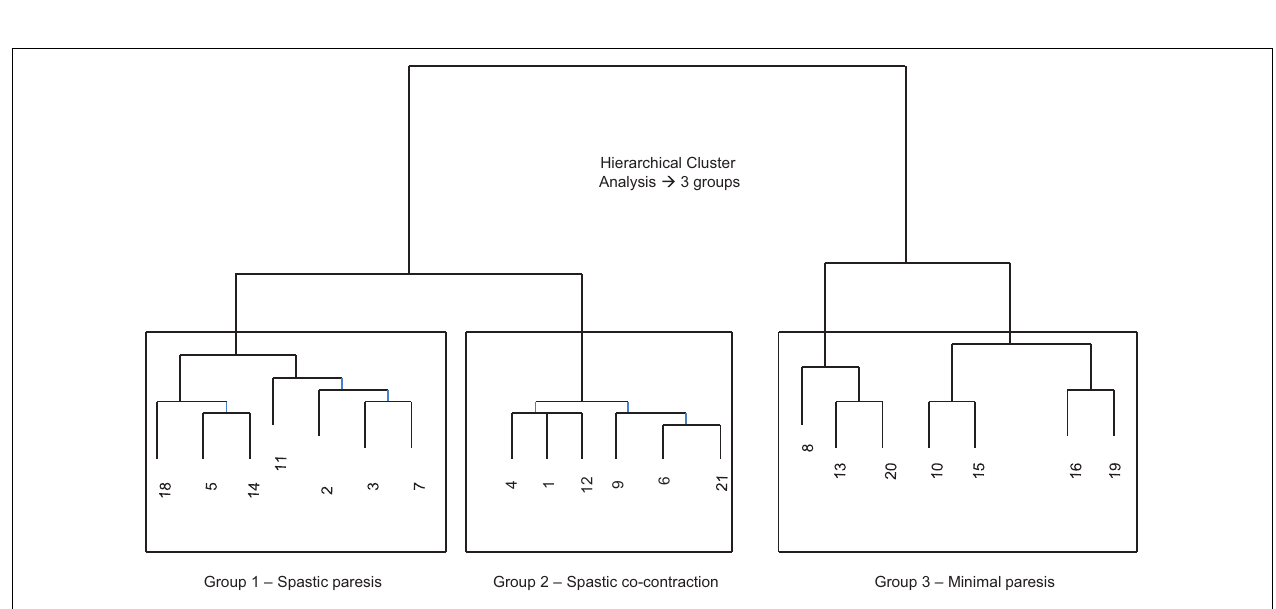
FIGURE 3 | Cluster dendrogram from hierarchical cluster analysis using the Mahalanobis metric based on speed and amplitude of wrist extension on the first trial with the paretic hand at baseline (without auditory stimulation) .Three distinct groups emerged.